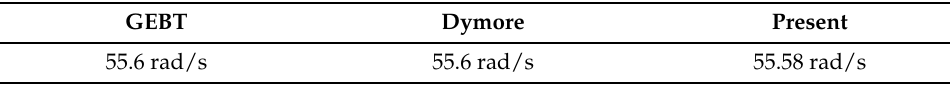
Table 2. Frequency of an uncoupled